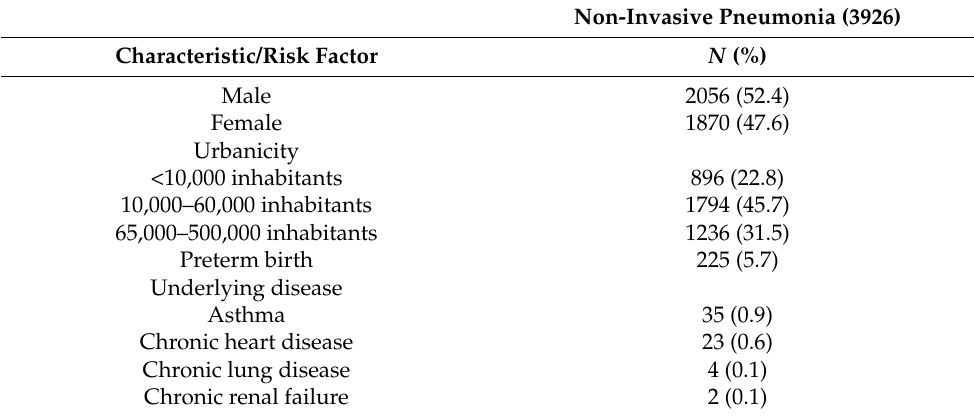
Table 4. Demographic characteristics and risk factors for non-invasive pneumonia in children.